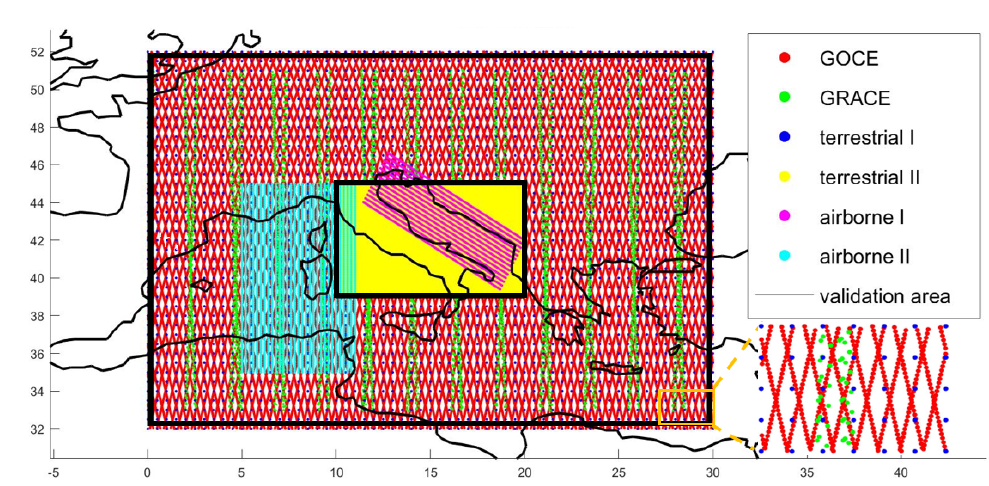
Figure 5. The study area as well as the GRACE, GOCE, terrestrial and airborne